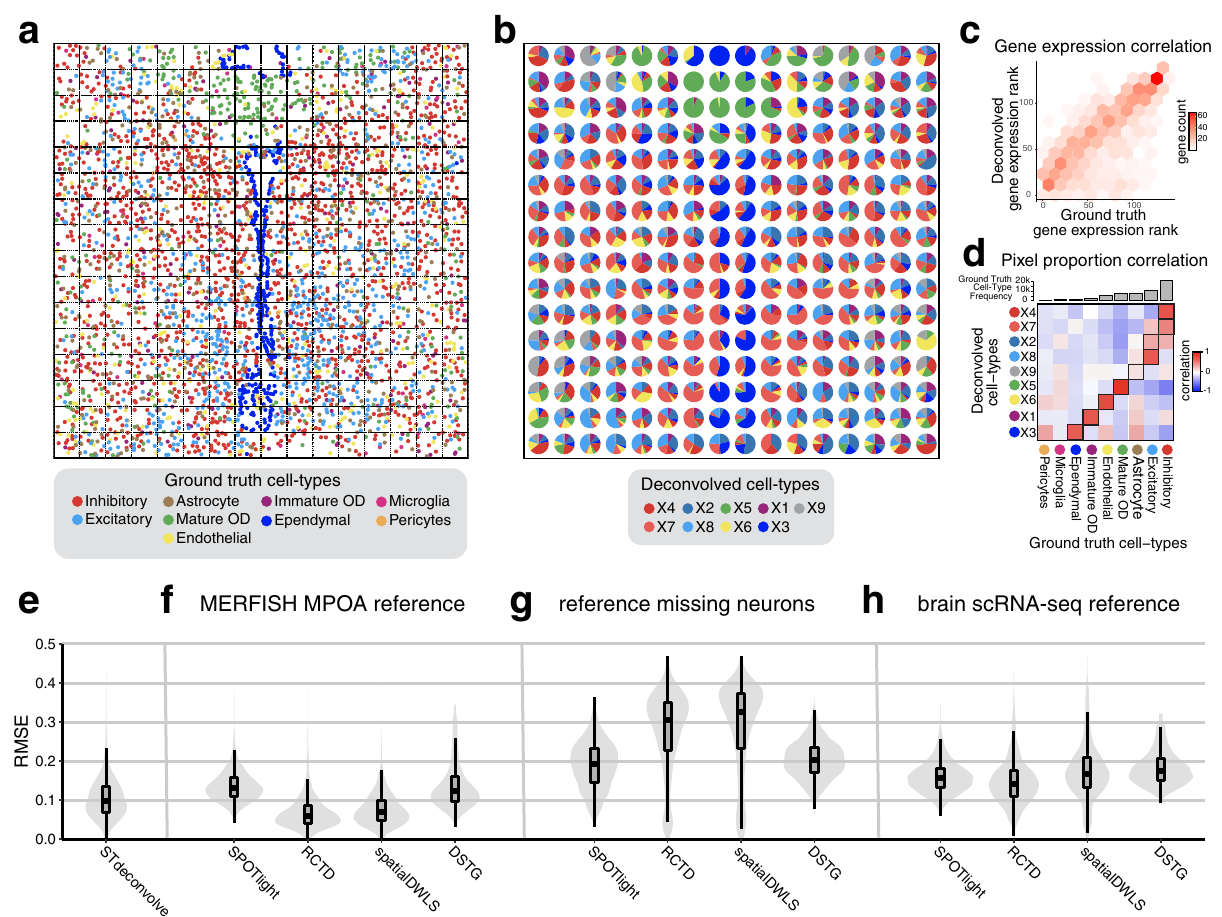
Fig. 2 Deconvolution of simulated ST data. a Ground truth single-cell resolution MERFISH data of one section of the MPOA partitioned into 100 µ m 2 pixels (black dashed squares). Each dot is a single cell colored by its ground truth cell type label. b Proportions of deconvolved cell types from STdeconvolve represented as pie charts for each simulated pixel. c The ranking of each gene based on its expression level in the deconvolved cell-type transcriptional pro fi les compared to its gene rank in the matched ground truth cell-type transcriptional pro fi les. d Heatmap of Pearson ’ s correlations between the deconvolved and ground truth cell type proportions across simulated pixels. Ground truth cell types are ordered by their frequencies in the ground truth dataset. Matched deconvolved and ground truth cell types are boxed. e Root-mean-square-error (RMSE) of the deconvolved cell-type proportions ( n = 3072 pixels) compared to ground truth for STdeconvolve, f for supervised deconvolution approaches using the ideal single cell transcriptomics MERFISH MPOA reference, g for supervised deconvolution approaches using the single cell transcriptomics MERFISH MPOA reference with missing neurons, and h for supervised deconvolution approaches using a brain single-cell RNA-seq reference. Boxplots indicate median (middle line), 25th, 75th percentile (box) and 5th and 95th percentile